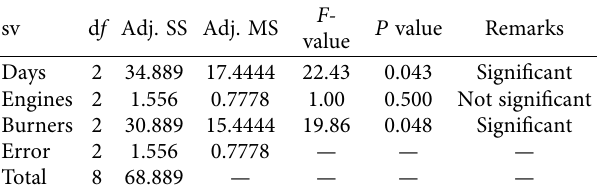
Figure 20: 3-D day vs engine vs. Table 8: ANOVA for the response.